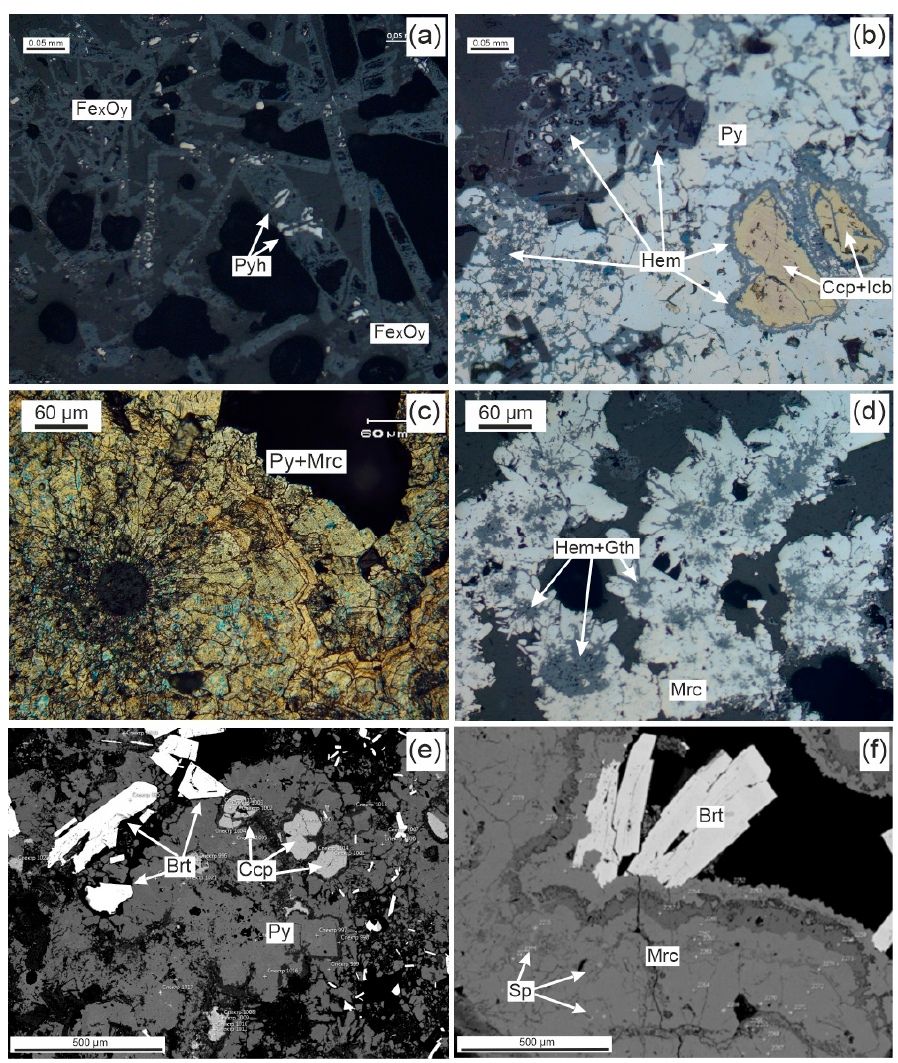
Figure 16. Textures and structures of sulfide samples from st. 373. ( a ) Relic pyrrhotite tabulars replaced by goethite in cavity (sample 373-4). BSE image. ( b ) Chalcopyrite with isocubanite bordered by hematite (sample 373-4). BSE image. ( c ) Radially layered aggregates of marcasite (sample 373- 3/1a). ( d ) Intergrowths of lamellar hematite in the center of marcasite dendrites (sample 373-4). BSE image. ( e ) Baryte intergrowth with sulfide minerals. BSE image. ( f ) Dissemination of sphalerite in marcasite. BSE image.